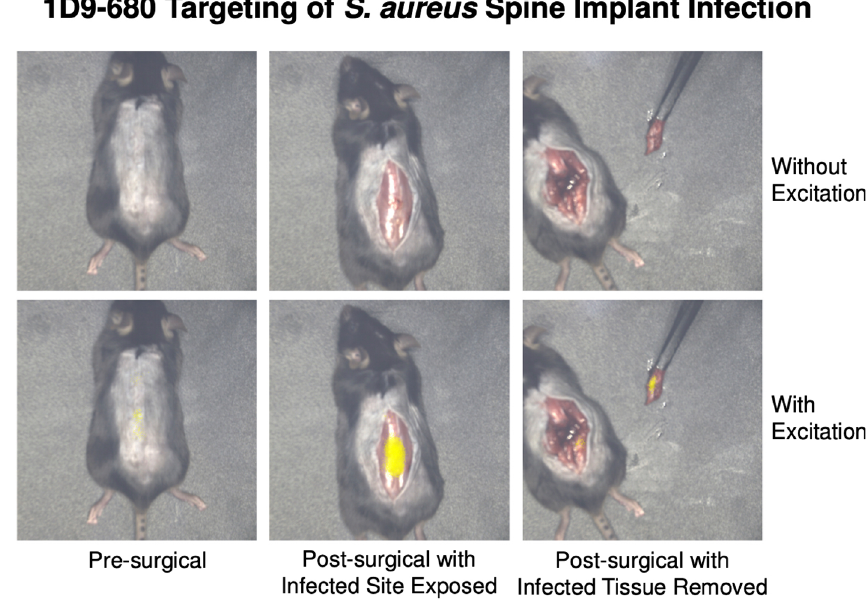
Figure 9. Image-guided surgical debridement of infected tissue in the spinal implant model. Image-guided surgery was performed utilizing the PerkinElmer Solaris Image-Guided Surgery System. Both the real-time white light images and fluorescence overlay images of a surgical debridement are shown. Pseudo-color yellow fluorescence can be seen in the pre-surgical panel, bottom image. Once the skin is opened, the wound bed is bright yellow in the bottom panel, which is indicative of the stronger probe signal. Following debridement of tissue, the bottom panel reveals no signal within the wound bed and persistent probe signal in the tissue specimen held by